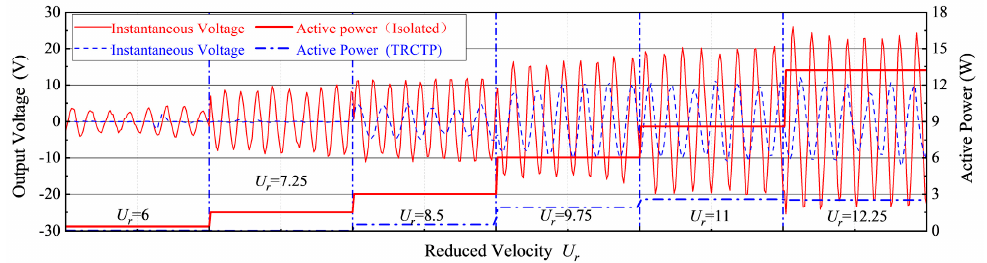
Figure 18. Active power and the instantaneous voltage for L / D = 1.5.